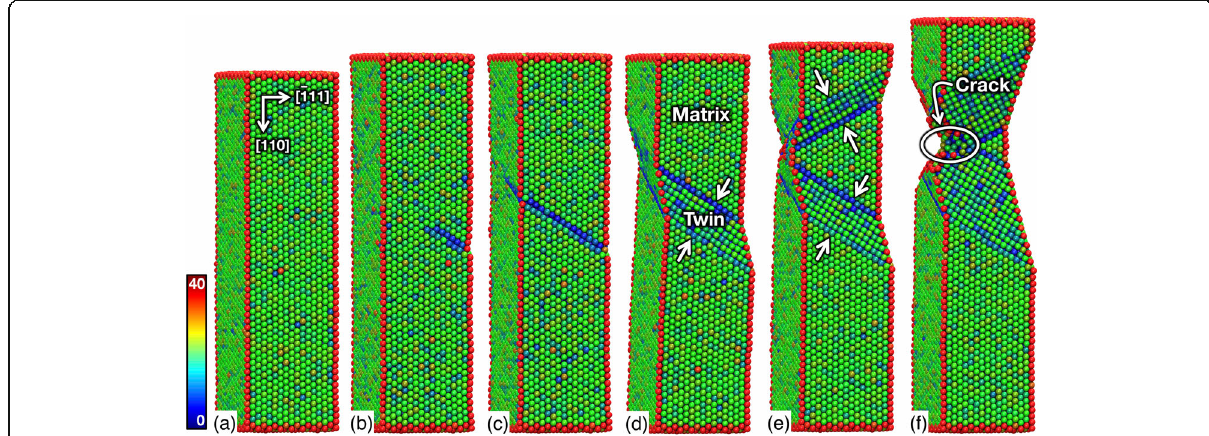
Fig. 3 Configuration of the computationally generated Al NW subjected to a tensile strain ( ) of ( a ) 0.02, b - d 0.05, e 0.07, and f 0.15, showing a sequence of the twin nucleation and subsequent migration. The atoms are colored to represent the defect structures in the NW according to the values of their centrosymmetry parameter (Kelchner et al. 1998)